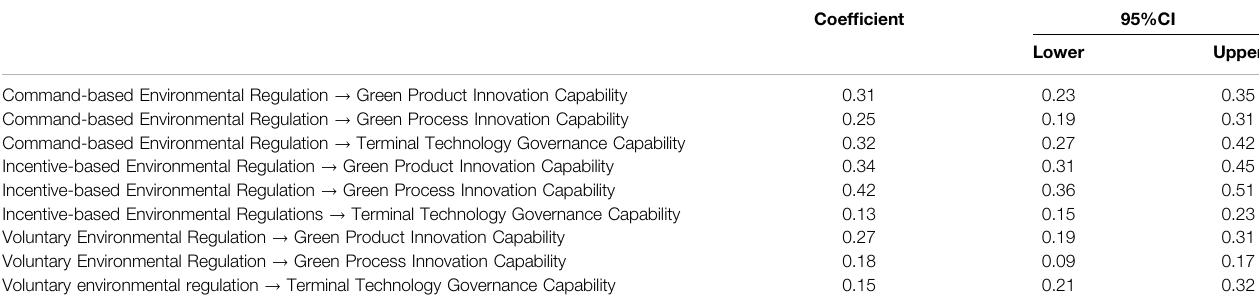
TABLE 4 | Results of the model path coef fi cient test.